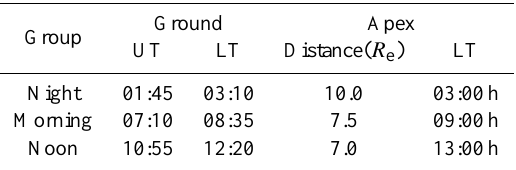
Table 7. Typical location of field line apex for each time-of-day